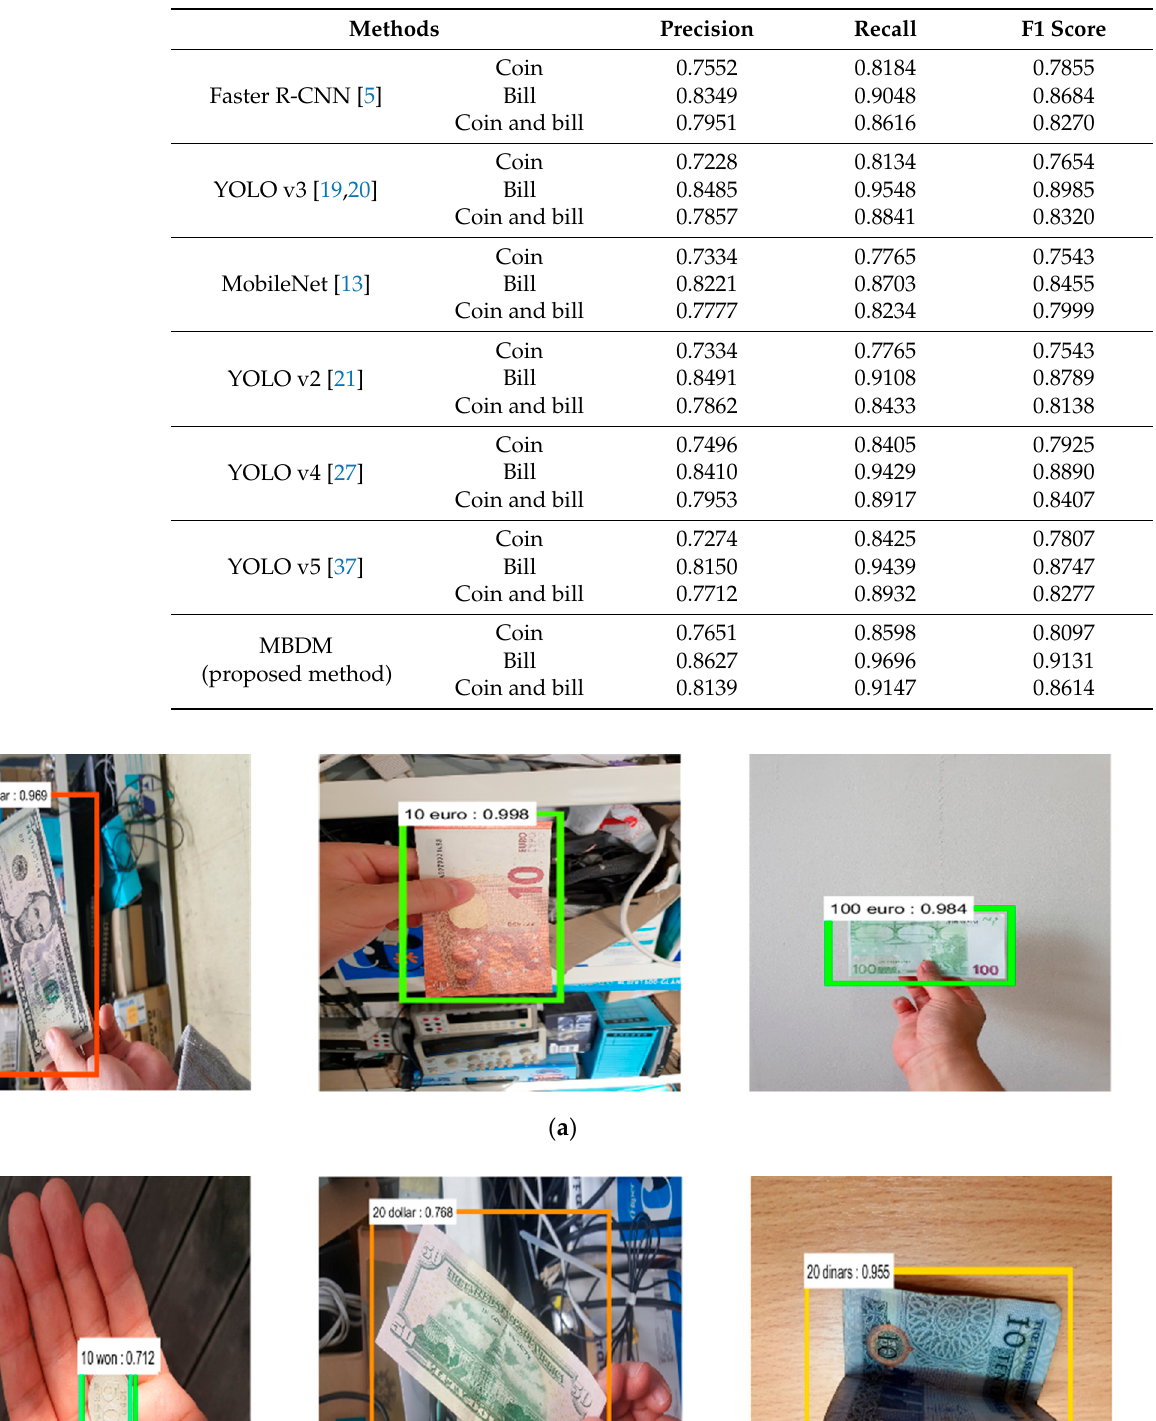
Table 12. Performance comparisons of the proposed method and the state-of-the-art methods with JOD.